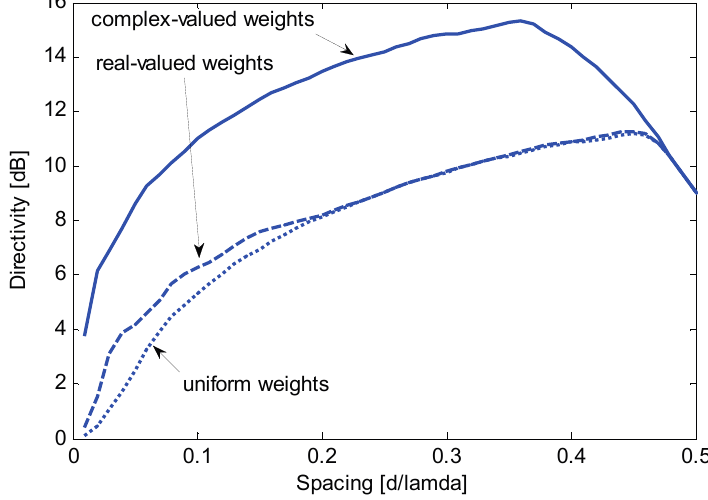
Figure 4. Maximum constrained directivity obtained for an end-fire array of N = 8 sensors by imposing WNG ≥ 0 dB using complex weights (solid line) or real weights (dashed line); the directivity obtained using uniform weights (dotted line) is included for comparison.